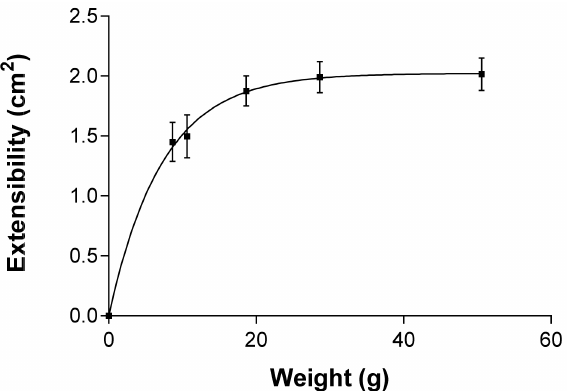
Figure 5. Extensibility profile of PF-NLCs-F127 hydrogel at 25 ◦ C ± 2 ◦ C; 60% ± 5% RH. The data were obtained from the mean of three experiments ( n = 3).